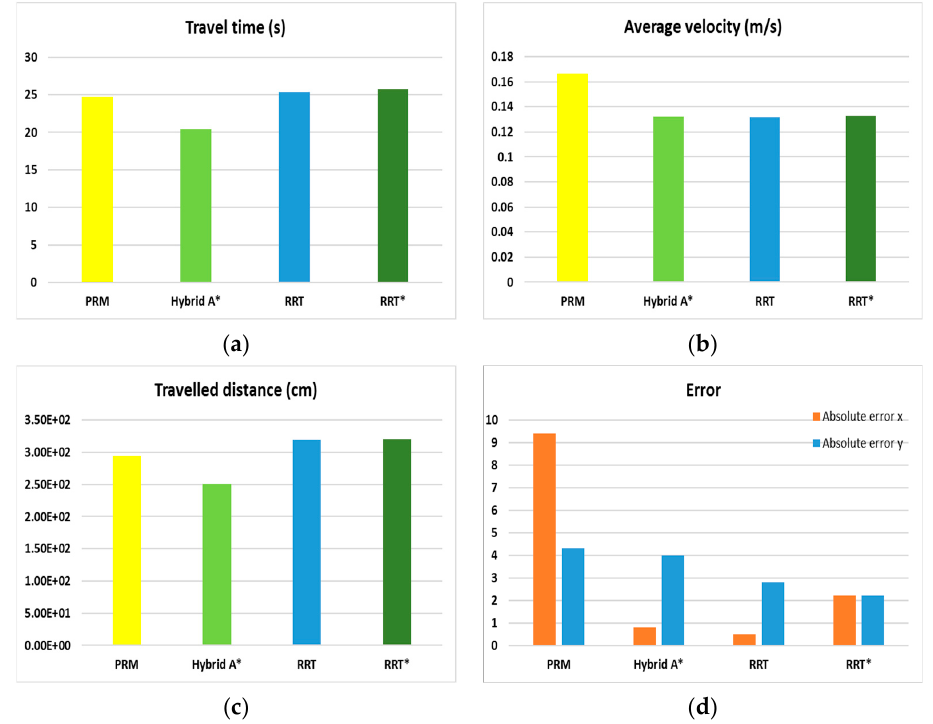
Figure 20. The experimental results that are generated by using different path-planning techniques in Map3. ( a ) The resultant traveled distance for different path planning techniques. ( b ) The resultant average velocity for different path planning techniques. ( c ) The resultant travel time for different path planning techniques. ( d ) The resultant absolute error for different path planning